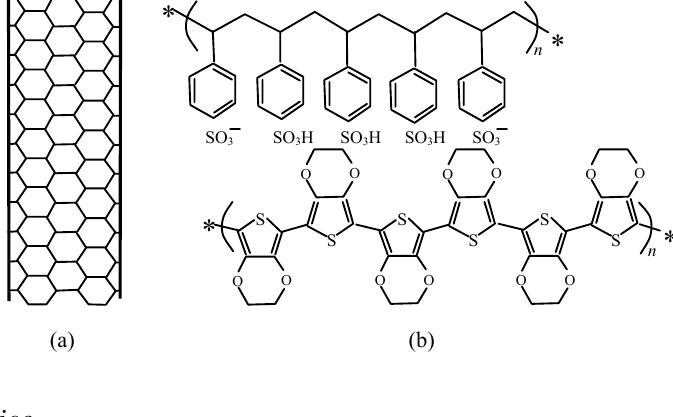
Figure 1. Components of the conducting inks used to develop the top electrode MWCNT ( a ), and PEDOT:PSS ( b